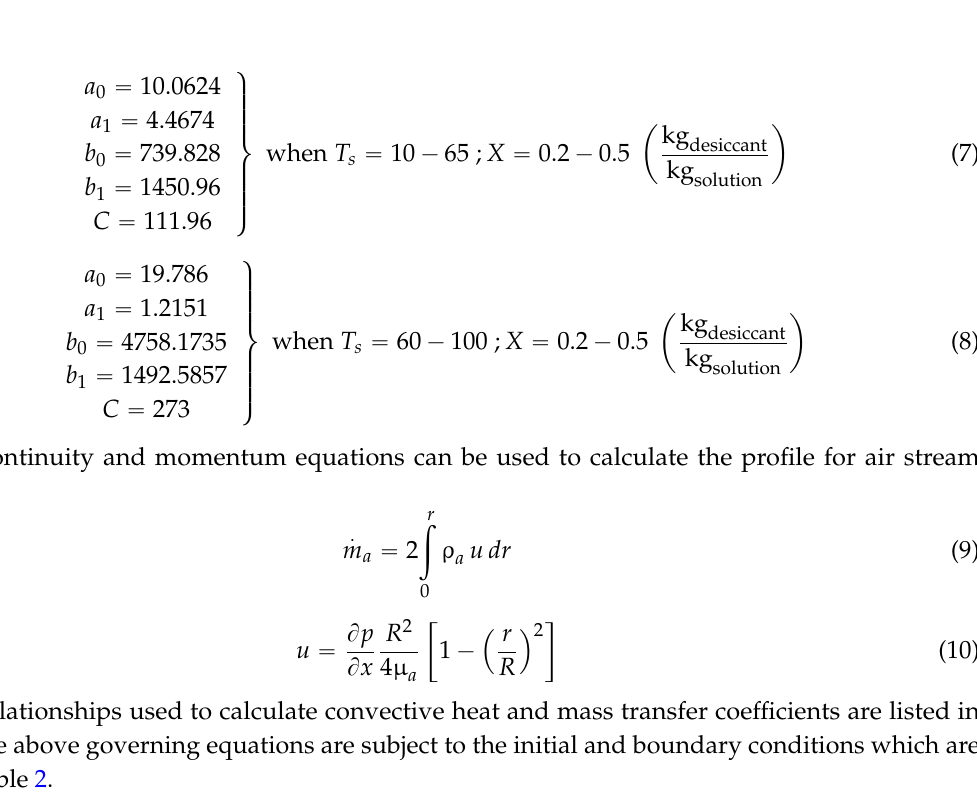
Table 1. Relationships for heat and mass transfer coefficients.